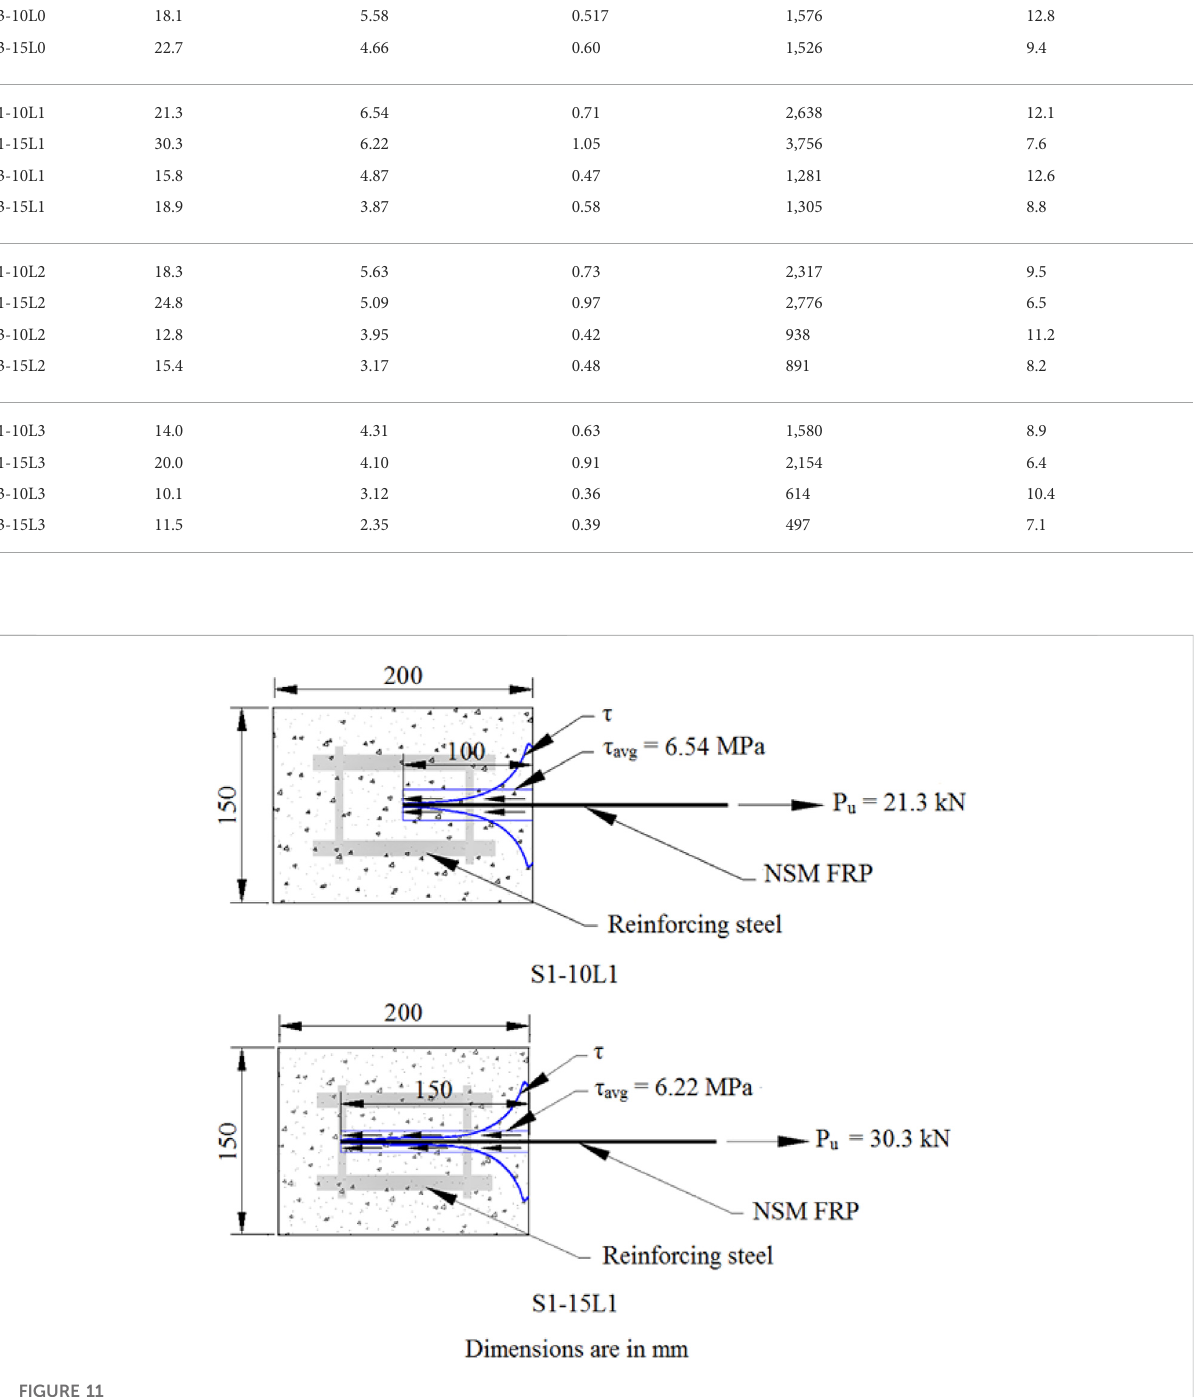
FIGURE 11 Schematics of the stress distribution for